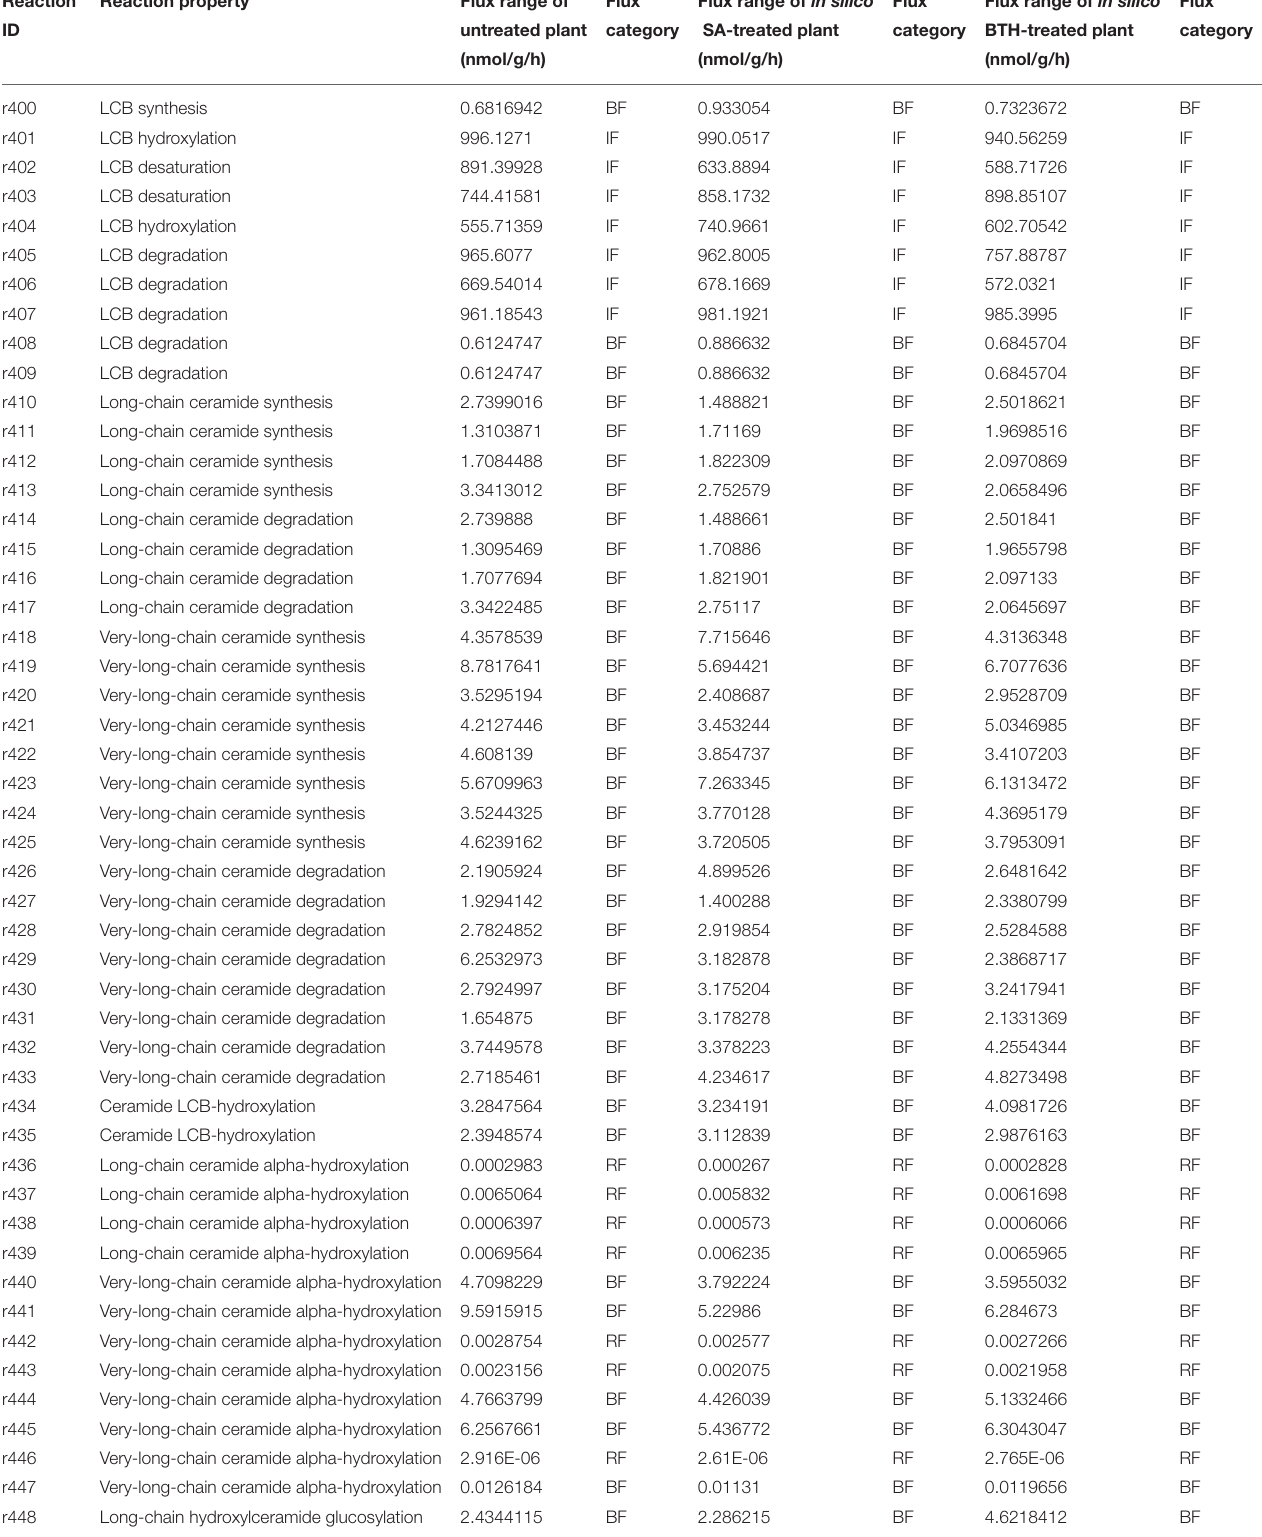
TABLE 3 | Simulated flux variability of sphingolipid-related reactions in untreated and SA-treated plants. Reaction Reaction